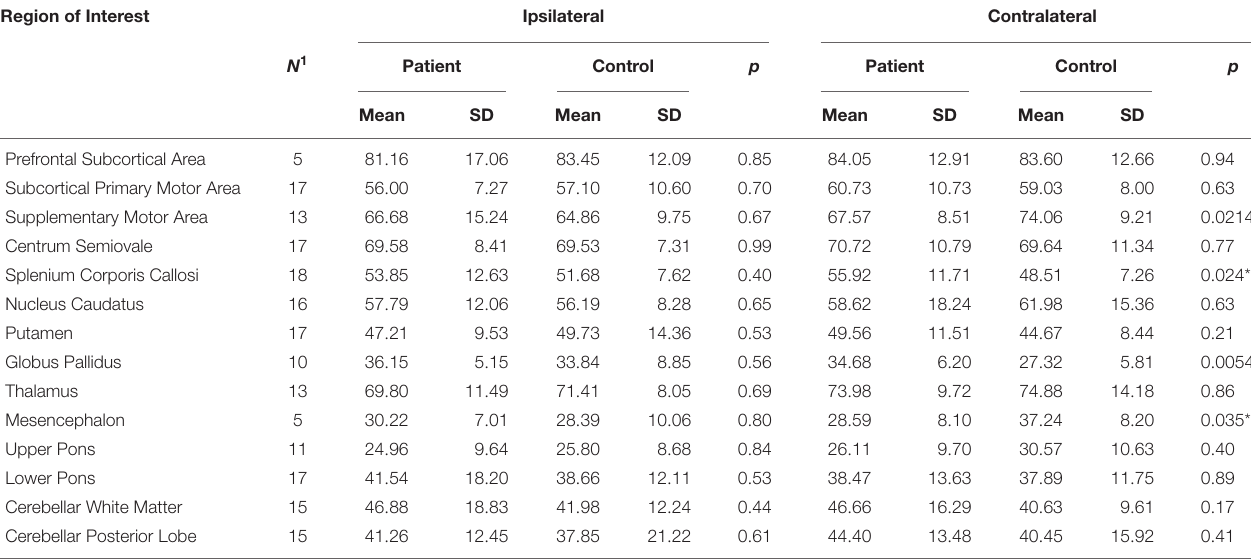
TABLE 5 | Paired t -tests between patients and controls for T2 (cid:48) measured in brain hemisphere contralateral or ipsilateral to the more affected body side as indicated. Region of